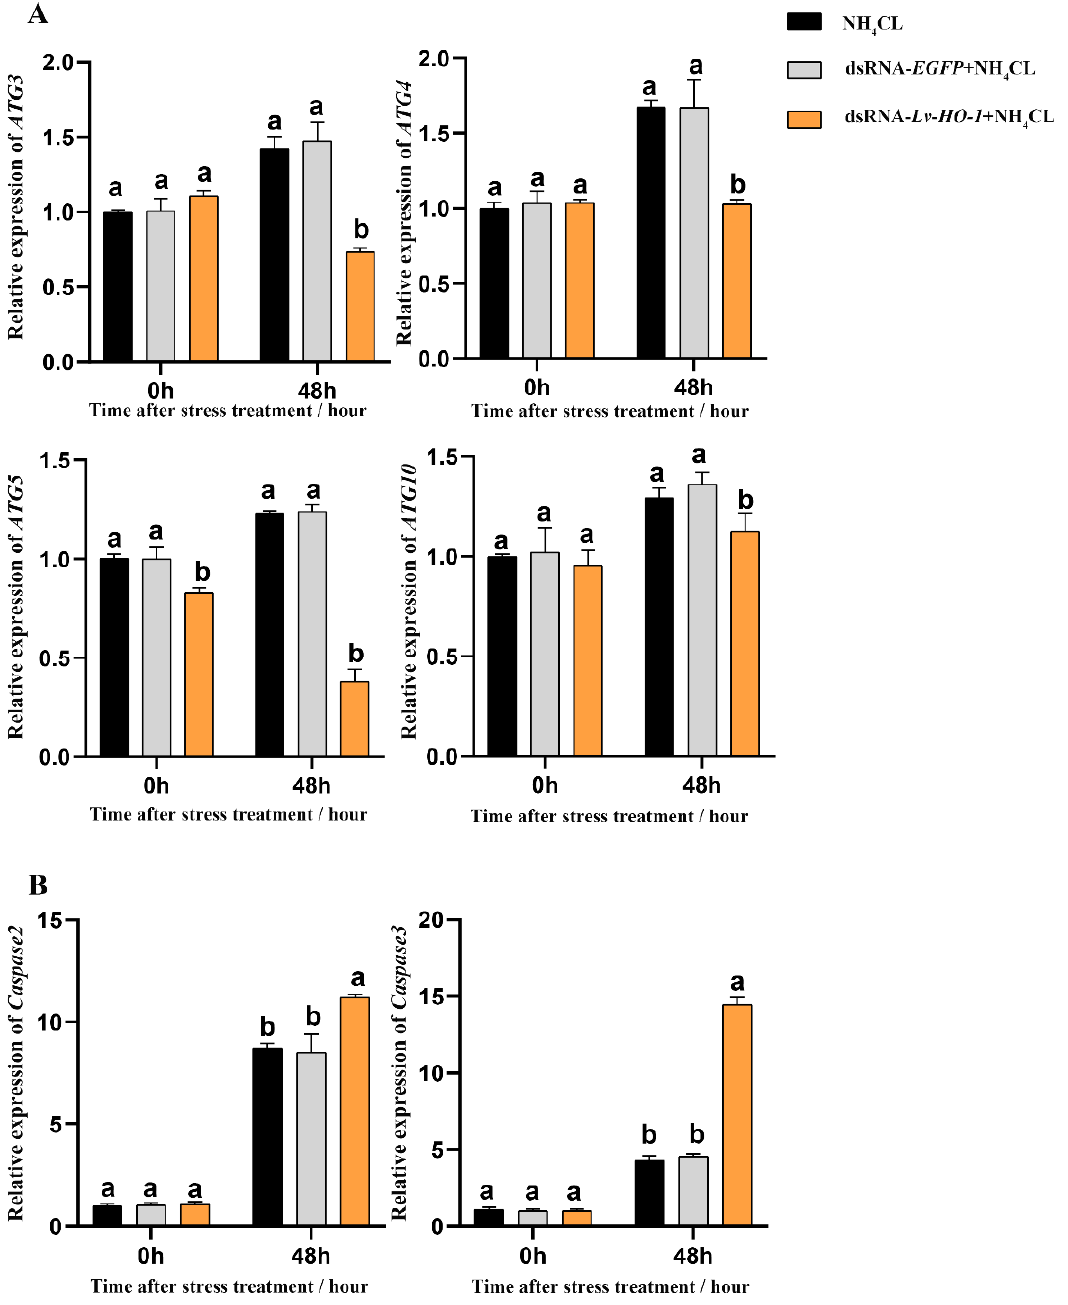
Figure 6. ( A ) Expression patterns of autophagy factors Atg3 , Atg 4 , Atg 5 , and Atg 10 as detected by qRT-PCR at different time points after ammonia exposure. ( B ) Expression patterns of apoptosis factors caspase-2 and caspase-3 as assessed via qRT-PCR at different time points after ammonia exposure. All values are the mean ± SD; n = 3. Different letters indicate a significant difference ( p < 0.05).